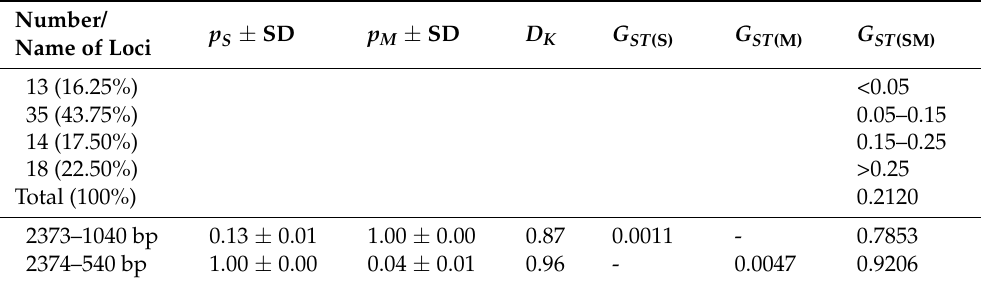
Table 5. Summary of iPBS locus-by-locus evaluation of genetic differentiation within and between P. sylvestris and P. mugo in